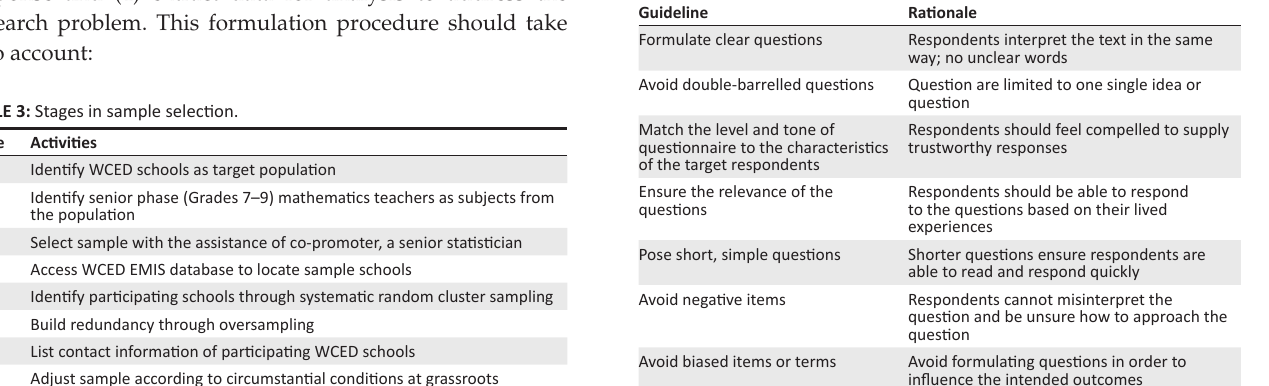
Stage 8: Create the questionnaire